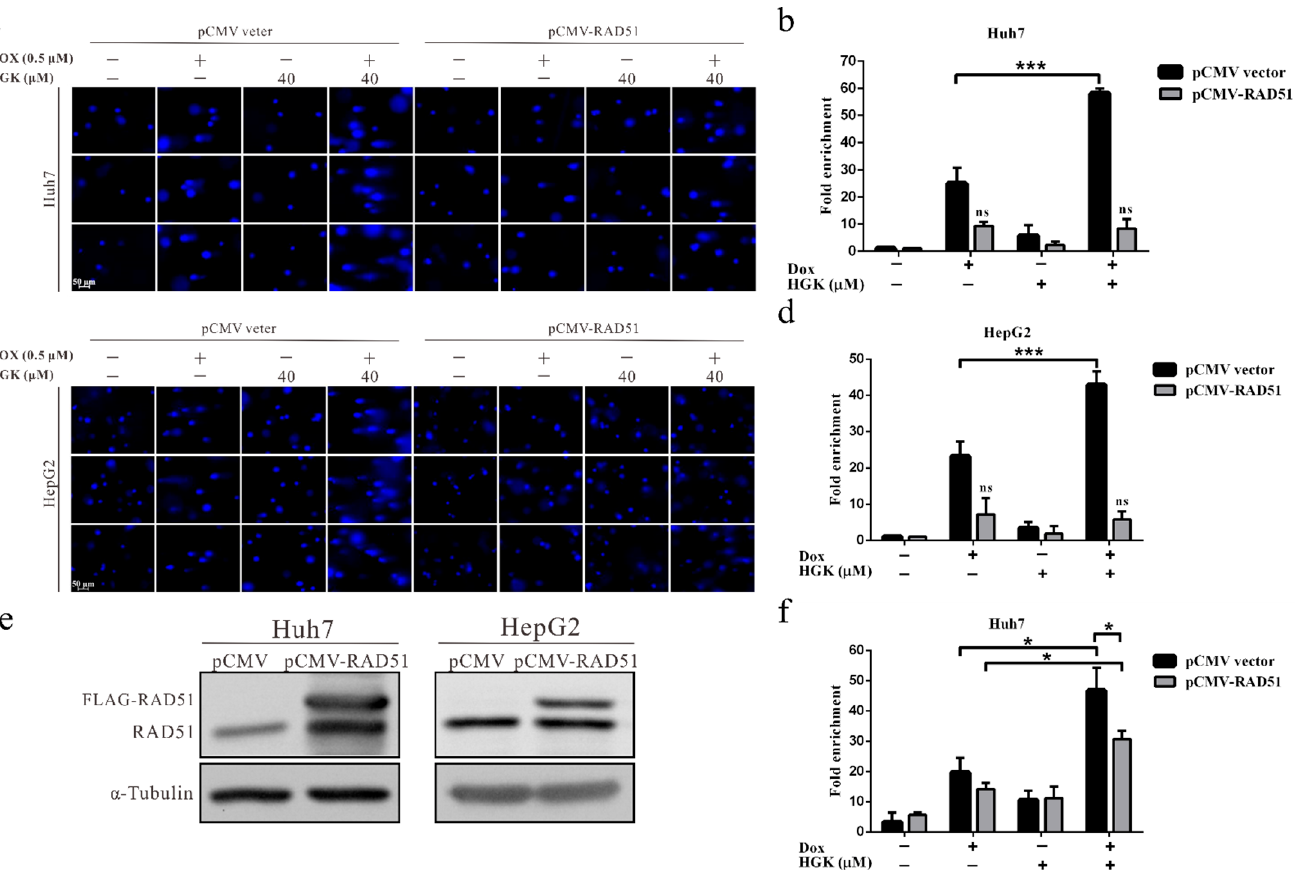
Figure 7. Hydroxygenkwanin (HGK) improves the efficacy of doxorubicin by inhibiting RAD51-mediated DDR in hepatocellular carcinoma cell lines. ( a , c ) Huh7 and HepG2 cells were transfected with pCMV-FLAG-RAD51 plasmid or vector for 48 h, followed by treatment with 40 μ M HGK and 0.5 μ M doxorubicin for 2 h. The cells were harvested and subjected to alkaline denaturing comet assay to assess the DNA repair activity. The results show that the overexpression of the RAD51 protein attenuates the inhibition of DNA repair by HGK in Huh7 and HepG2 cells. ( b , d ) Quantitative results of the cell repair activity. Data were expressed as mean ± standard deviation of three independent experiments. p < 0.05 (*), p < 0.001 (***). ( e ) Western blotting analysis shows the expression of FLAG-tagged RAD51 and endogenous RAD51 in transfected cells. ( f ) Trypan blue staining shows that HGK enhances doxorubicin-induced apoptosis, whereas RAD51 overexpression significantly decreases the apoptosis ratio.